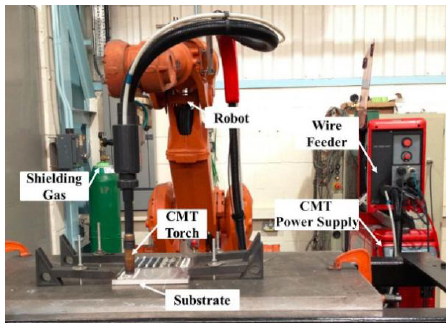
Figure 1. Cold metal transfer ‐ wire + arc additive manufacturing experimental system.